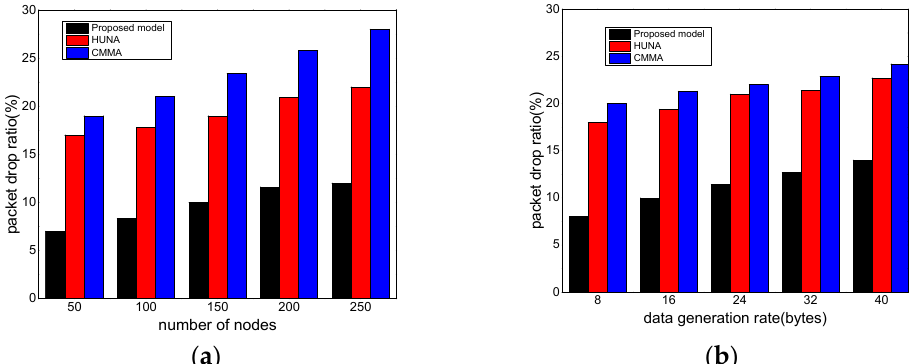
Figure 4. Performance of packet drop ratio with the number of nodes ( a ) and packet generation rate ( b ).